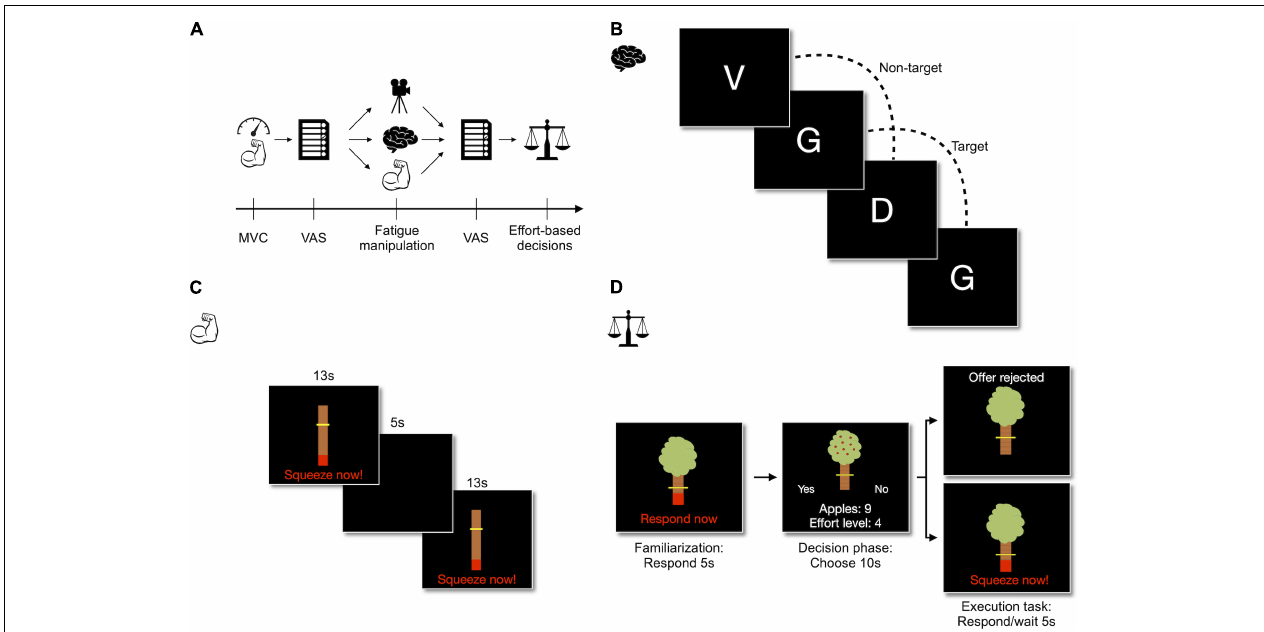
FIGURE 1 | Experimental and task procedures. MVC, Maximum Voluntary Contraction; VAS, Visual Analog Scales measuring cognitive fatigue and physical fatigue. (A) Participants visited the lab on three occasions. In each visit, participants underwent one of the three fatigue manipulations (i.e., documentary watching, 2-back task or handgrip exercise) before and after which subjective cognitive and physical fatigue were assessed on a single-item VAS-scale. At the end of each visit, participants performed the effort-based decision-making task. (B) In the 2-back task, participants responded to letters appearing on the computer screen. Participants indicated whether the presented letter was the same as two letters before by pressing the corresponding key on a keyboard (“Z” = target, “M” = non-target). (C) In the 45-min handgrip exercise, participants squeezed at the required force level for 13 s after which they had a short break of 5 s. (D) The effort-based decision-making task consisted of three subtasks. In the familiarization task, participants squeezed at the different force levels (16–80% of MVC) for 5 s. In the decision-making task, participants indicated whether they accepted the offer by pressing the left or right arrow key on the keyboard (position of “yes” and “no” varied per trial). In the execution task, participants performed 40% of the choices made in the decision-making trials. They either squeezed at the required force level for 5 s to obtain the reward of accepted offers or waited for 5 s on the rejected offers. On all squeezing tasks (handgrip exercise, familiarization task and execution task), the yellow bar represented the required force level while the red filling indicated the force participants were currently delivering. Panel D: Adapted from Le Heron et al. (2018). CC BY